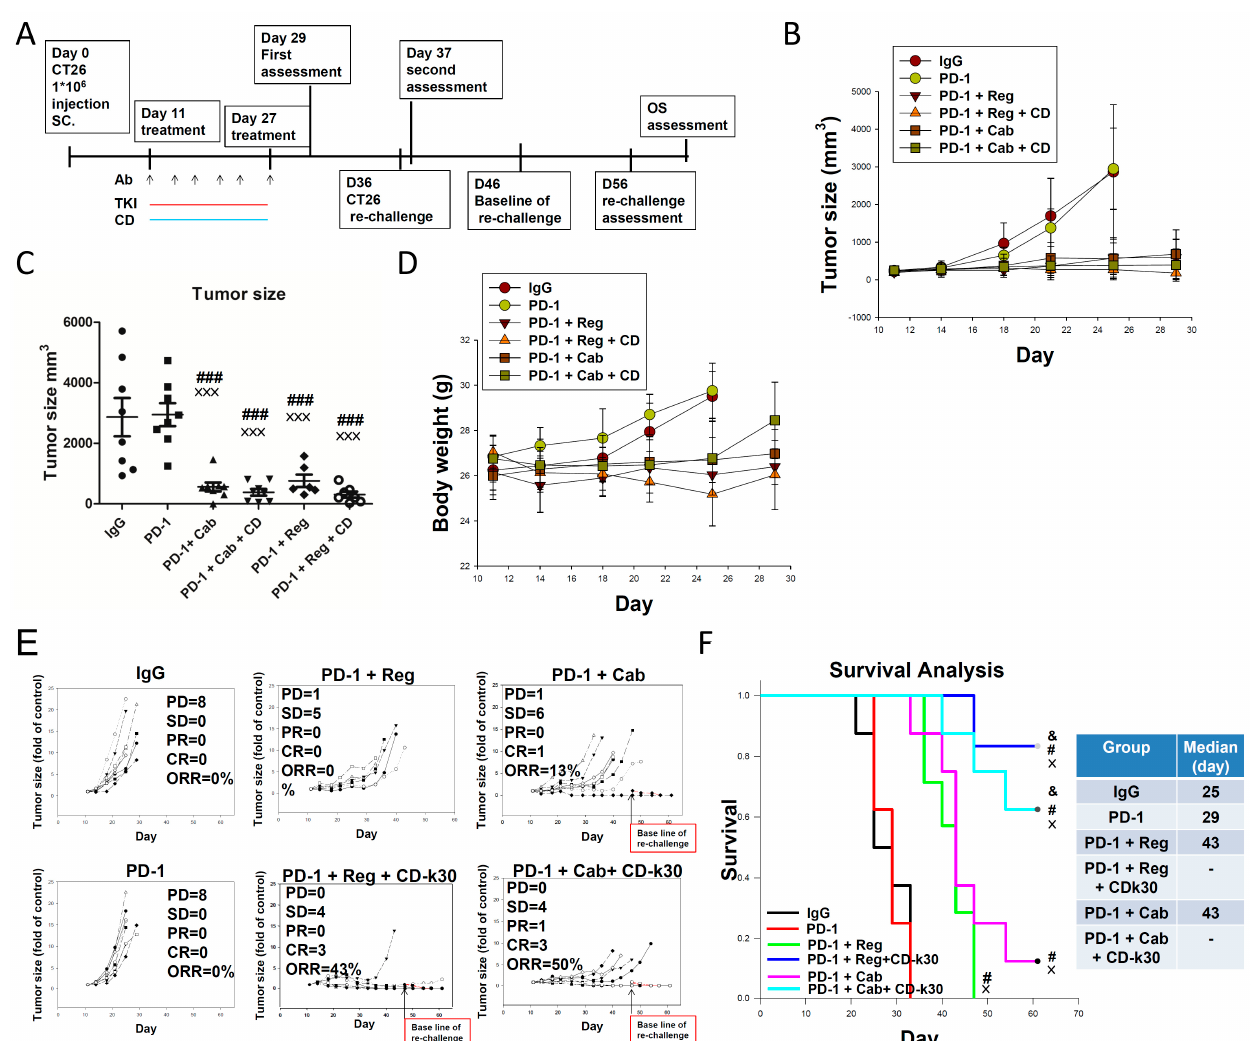
Figure 1. ( A – F ) shows the results of therapeutic responses to Cabozantinib or Regorafenib combined with Chidamide-k30 plus anti-PD-1 antibody in CT26 tumor-bearing mice. Balb/c mice bearing a CT26 tumor were treated with various therapeutic modalities as indicated. The combination with Cabozantinib/ Regorafenib is shown in ( A ) consecutive treatment schedule ( B ) total tumor volumes ( C ) Endpoint evaluated tumor volumes at D25 ( D ) Mice body weights ( E ) Individual tumor volumes ( F ) animal survival rates. CT26 tumor-bearing mice were treated as indicated and euthanized at a tumor volume of 3000 mm 3 after tumor implantation. After 16-day treatment followed by tumor assessment, the mice with CR and PR response were re-inoculated with CT-26 cancer cells into the opposite flank in a rechallenge experiment. Red line squares indicates re-inoculated CT26 tumor growth in rechallenge experiment. Data are given as mean ± SD; × p < 0.05, ×× p < 0.01, ××× p < 0.001, ### p < 0.001, one-way ANOVA with Tukey’s test. × , compared to IgG; #, compared to PD-1, & compared to PD-1 + Reg. ( n = 6–8).